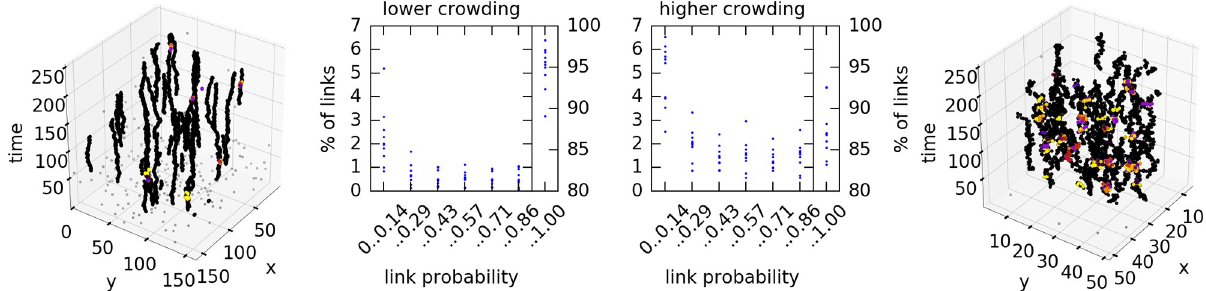
Fig 6. Change of the distribution depending on the track density. The left histogram shows the link probability of 10 data sets with lower birth rate. One of the data sets is shown in the left 3D plot. The histogram on the right shows the link probability of 10 data sets with higher birth rate. In comparison with the low-birth-rate data sets, the high-birth-rate data sets have fewer links with very high probabilities, while the number of links with medium and low probability is increased. This higher uncertainty of some links is due to the higher